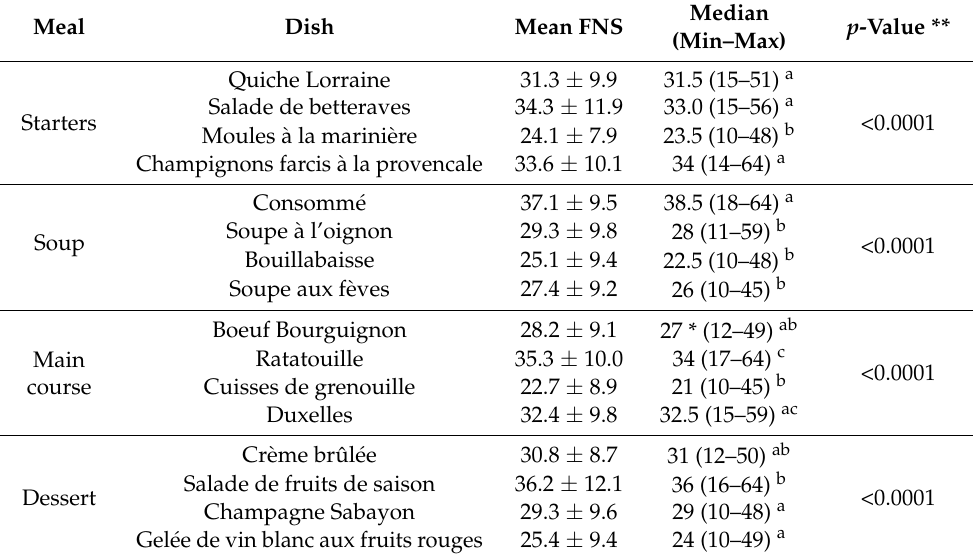
Table 5. The comparison of food neophobia levels among the studied sample of young Polish women organized into sub-groups stratified according to dish choices from the model French restaurant